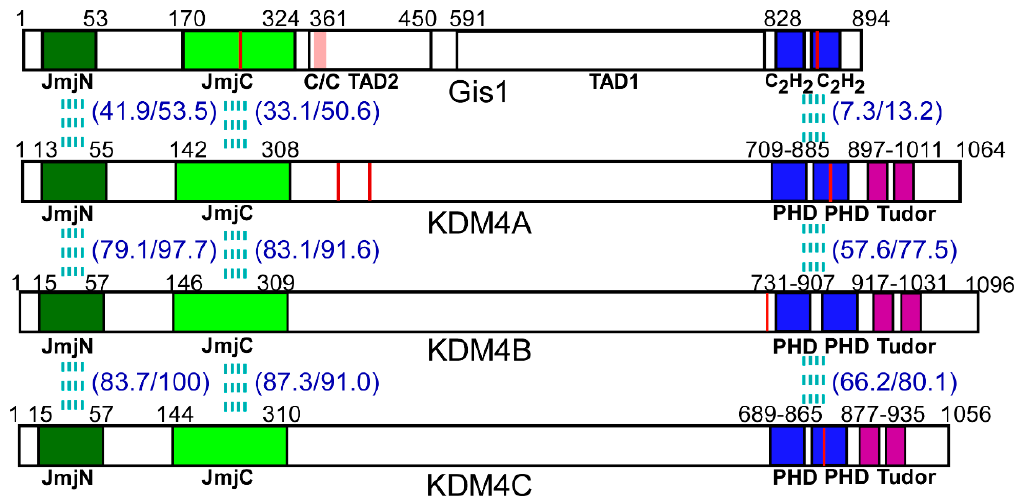
Figure 1. The structure and alignment of Gis1 and KDM4A/B/C domains. The domains of Gis1 and KDM4s are shown. Gis1 contains the JmjN + JmjC (JmjN/C) domain, the coiled-coil domain (C/C), two C2H2 type zinc fingers (ZnFs), and two transcription activation domains (TAD1 and TAD2). KDM4A/B/C proteins contain the JmjN/C domain, two PHD domains (each containing a conserved C4HC3 or C4HC2H motif), and two Tudor domains. The red lines represent cysteine-proline (CP) motifs, black lines indicate the start and end of the shown domains, and the pink box in the Gis1 structure denotes the coiled-coil domain. The % amino acid identity and similarity between Gis1 and KDM4s in JmjN/C and zinc finger domains are shown in parentheses.